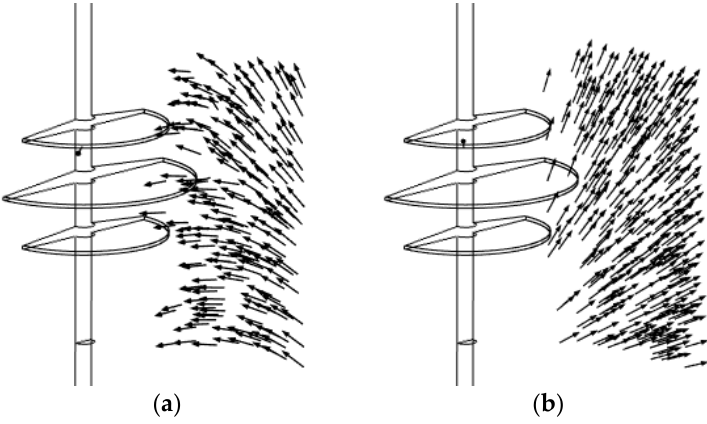
Figure 7. The direction map of ( a ) air drag force and ( b ) electric force on particles at 0.28 s after release.